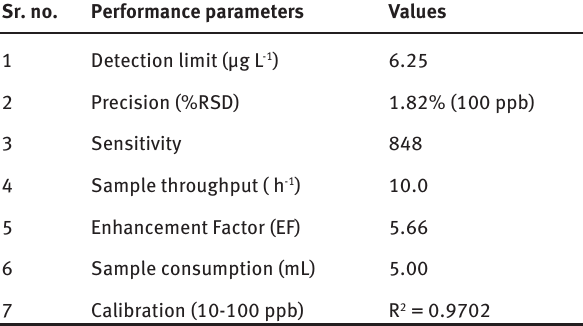
Table 2: Flow injection system performance for online preconcentration and determination of Cr(VI) at optimized conditions. Sr. no.